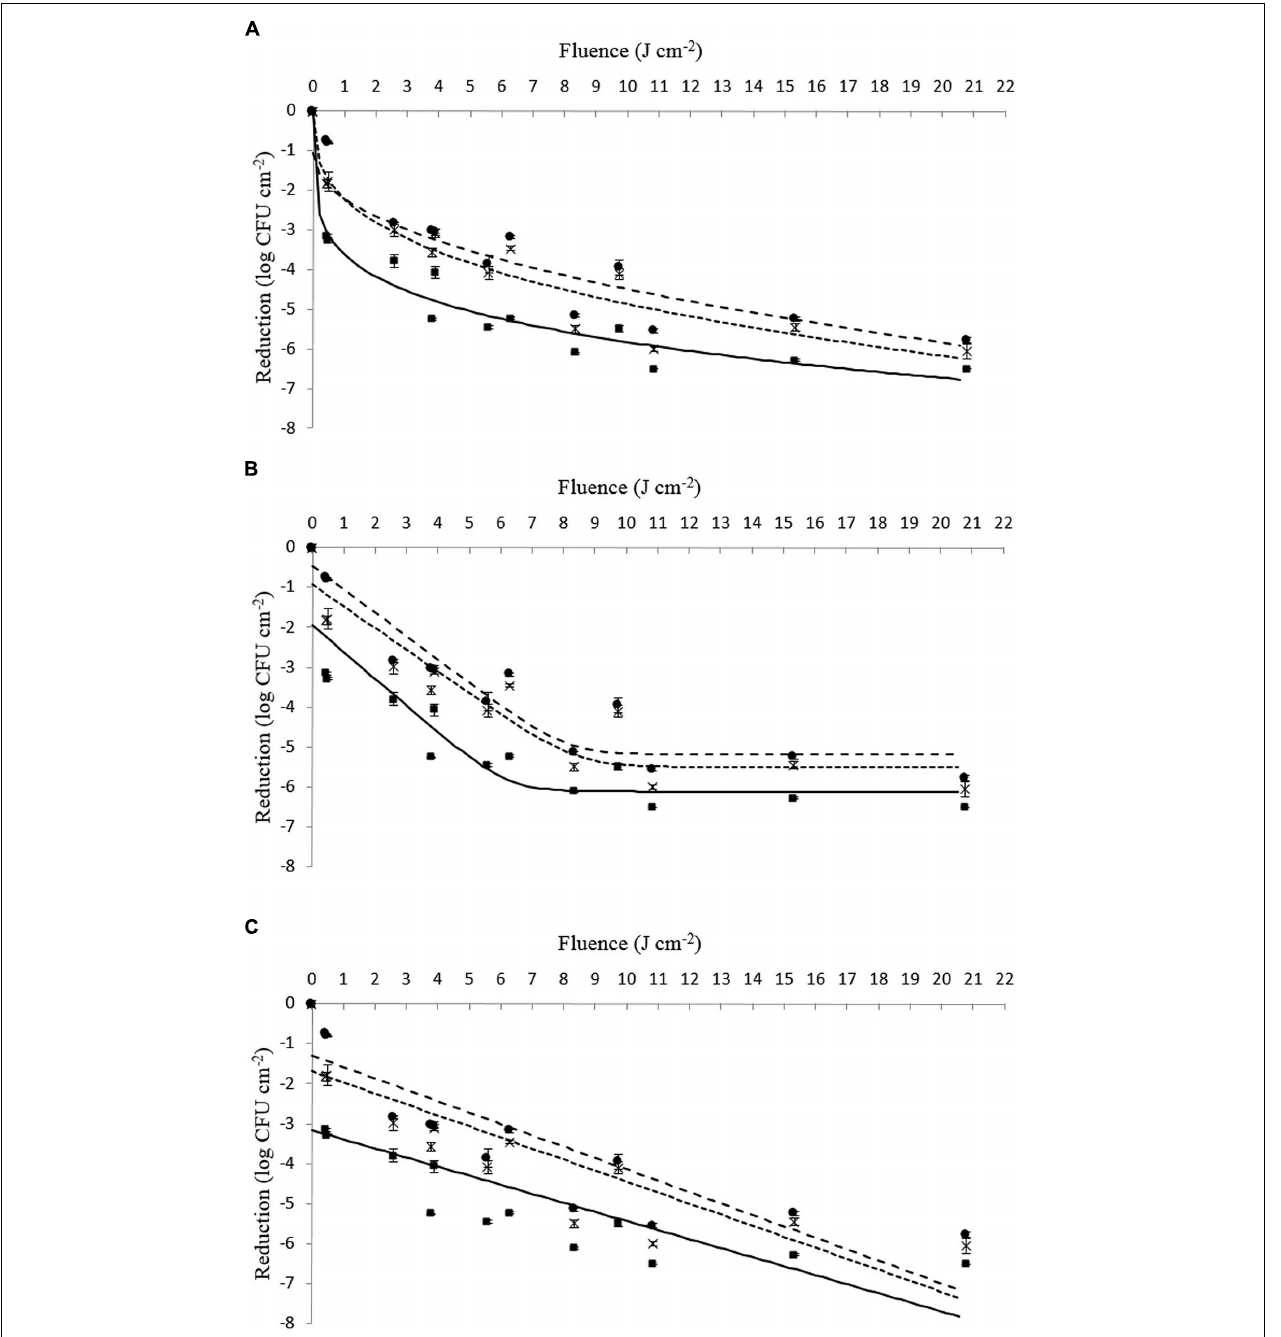
FIGURE 2 | (A–C) Survival (log CFU cm − 2 ) of viable counts of L. monocytogenes Li-P492 inoculated on Tryptone Soya Agar supplemented with Yeast Extract when exposed to different PL treatment intensities (0.46 ± 0.16 to 20.78 ± 0.15 J cm − 2 ). The symbols represent observed means for control ( (cid:4) ), tolerant ( ) as well as tolerant and stored strains (x). The lines represent the respective mathematical inactivation models calculated on basis of the observed values for control (solid line), tolerant (dotted line) as well as tolerant and stored strains (dashed line). (A) Weibull-type model. (B) Log – linear + tail model. (C) Log – linear